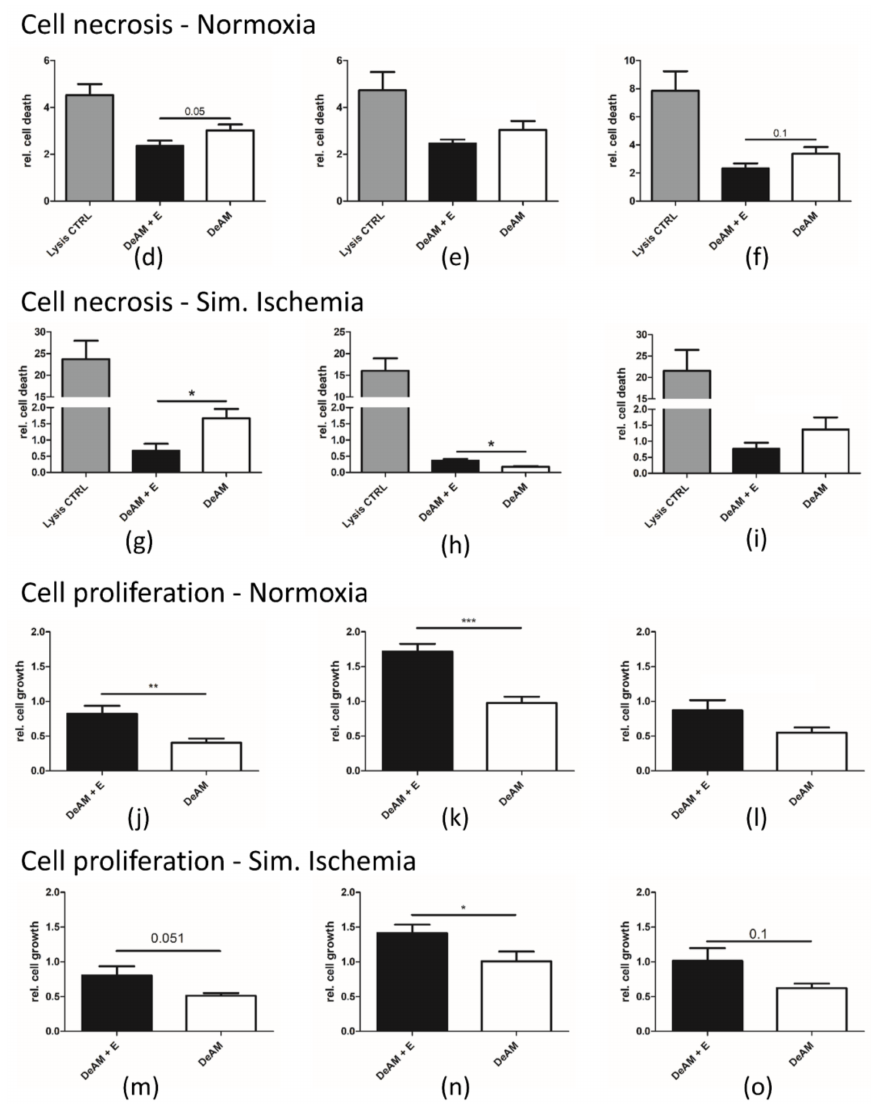
Figure 4. Interaction and viability of HL-1 cells, EPDCs and hCF cultured on DeAM and DeAM + E scaffolds. Adhesion capacity of contractile ( a ) HL-1 cells, ( b ) EPDCs and ( c ) hCF was determined via calcein staining on DeAM (dotted line) and DeAM + E (solid line). Cell necrosis was determined by measuring LDH release of HL-1 cells, EPDCs and hCF under normoxia ( d – f ) and “simulated ischemia” ( g – i ) cultured on DeAM + E (black) and DeAM (white). Lysis control (grey) indicates total cell death. Cell growth was determined by measuring BrdU-incorporation of HL-1 cells, EPDCs and hCF under normoxia ( j – l ) and “simulated ischemia” ( m – o ) cultured on DeAM + E (black) and DeAM (white). * p < 0.05, ** p < 0.01, *** p < 0.001; n ≥